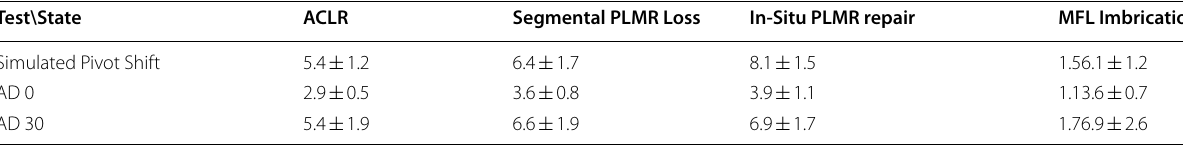
Table 2 Mean ATT (mm) by State (columns) and Test (rows) Test\State ACLR